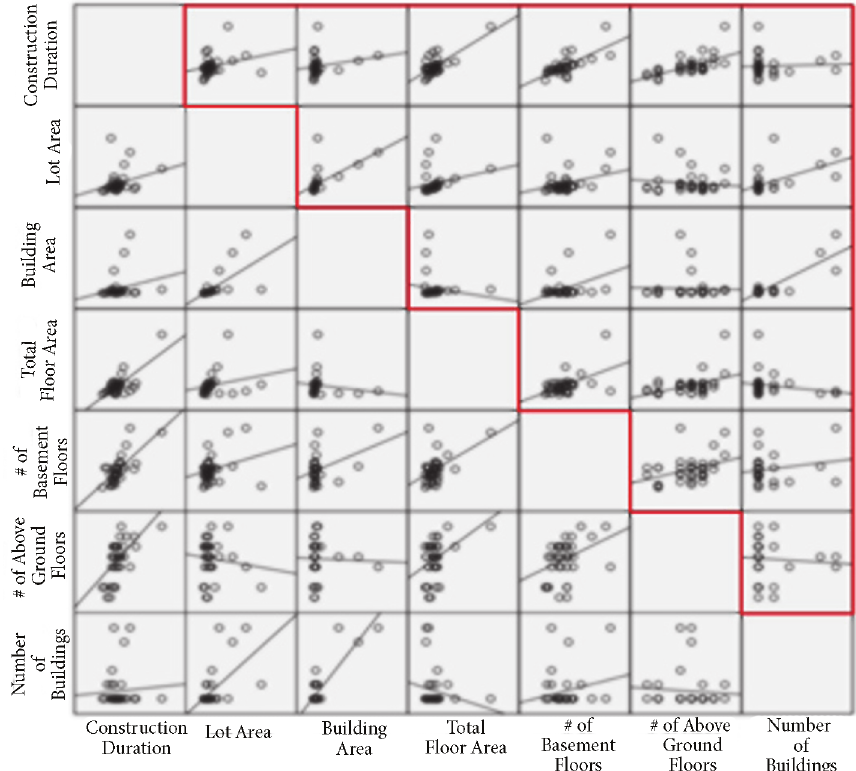
Figure 5. Matrix of scatter plots between the construction duration and scale